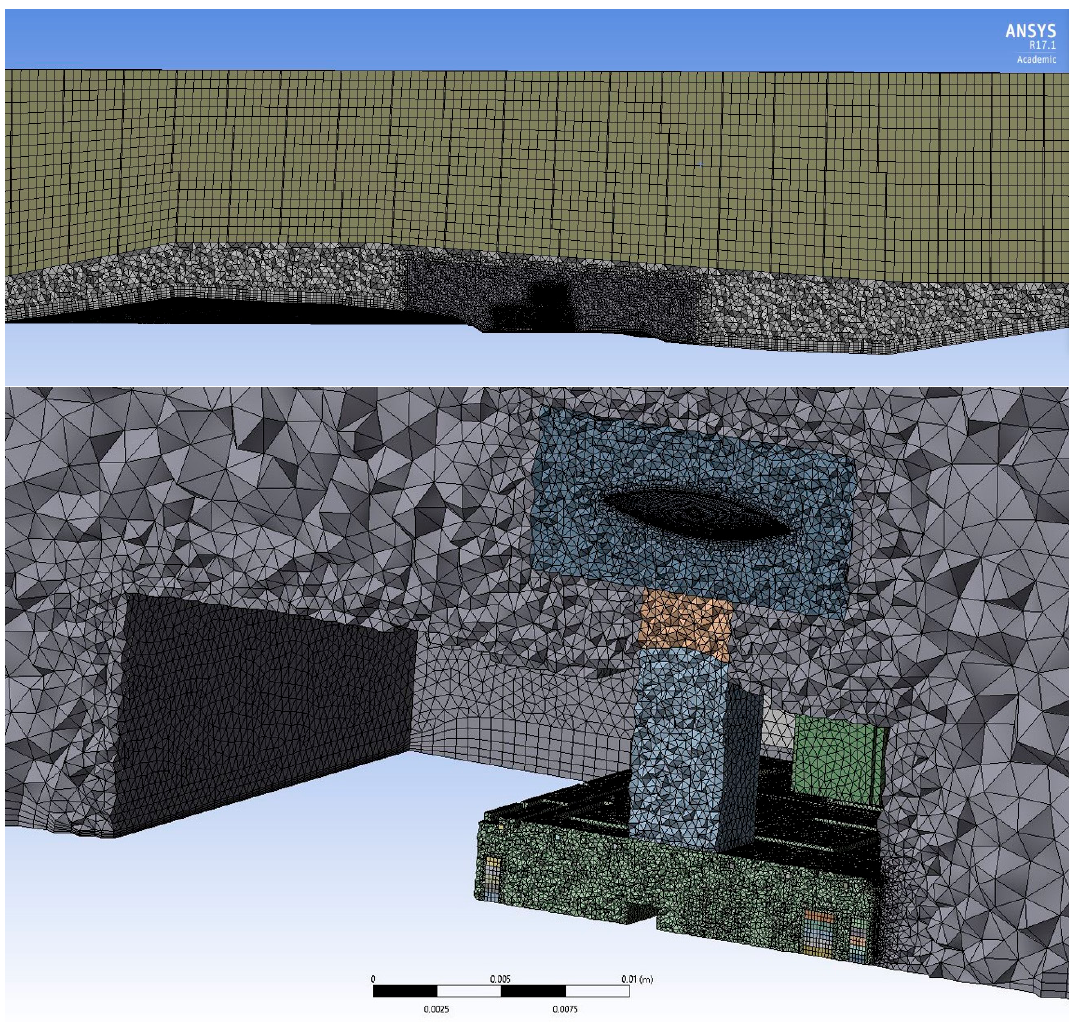
Figure 9. The volume mesh section from far view (top) and close view (bottom).